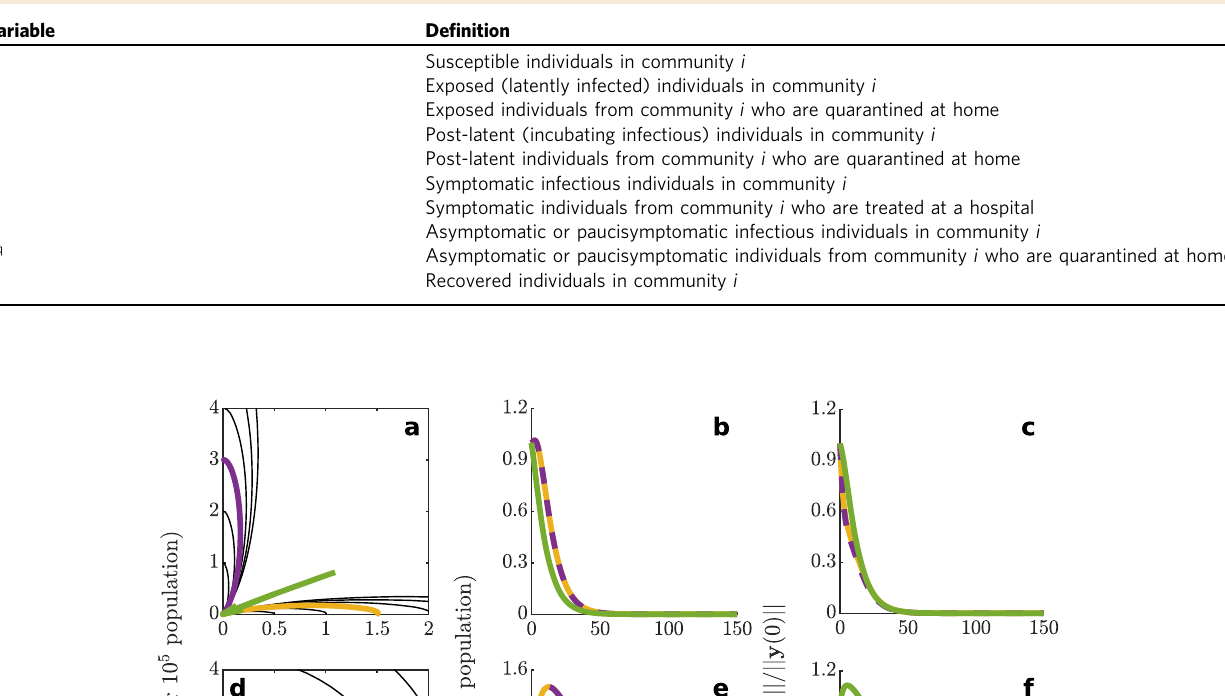
Table 1 State variables of model (Eq. (3)).